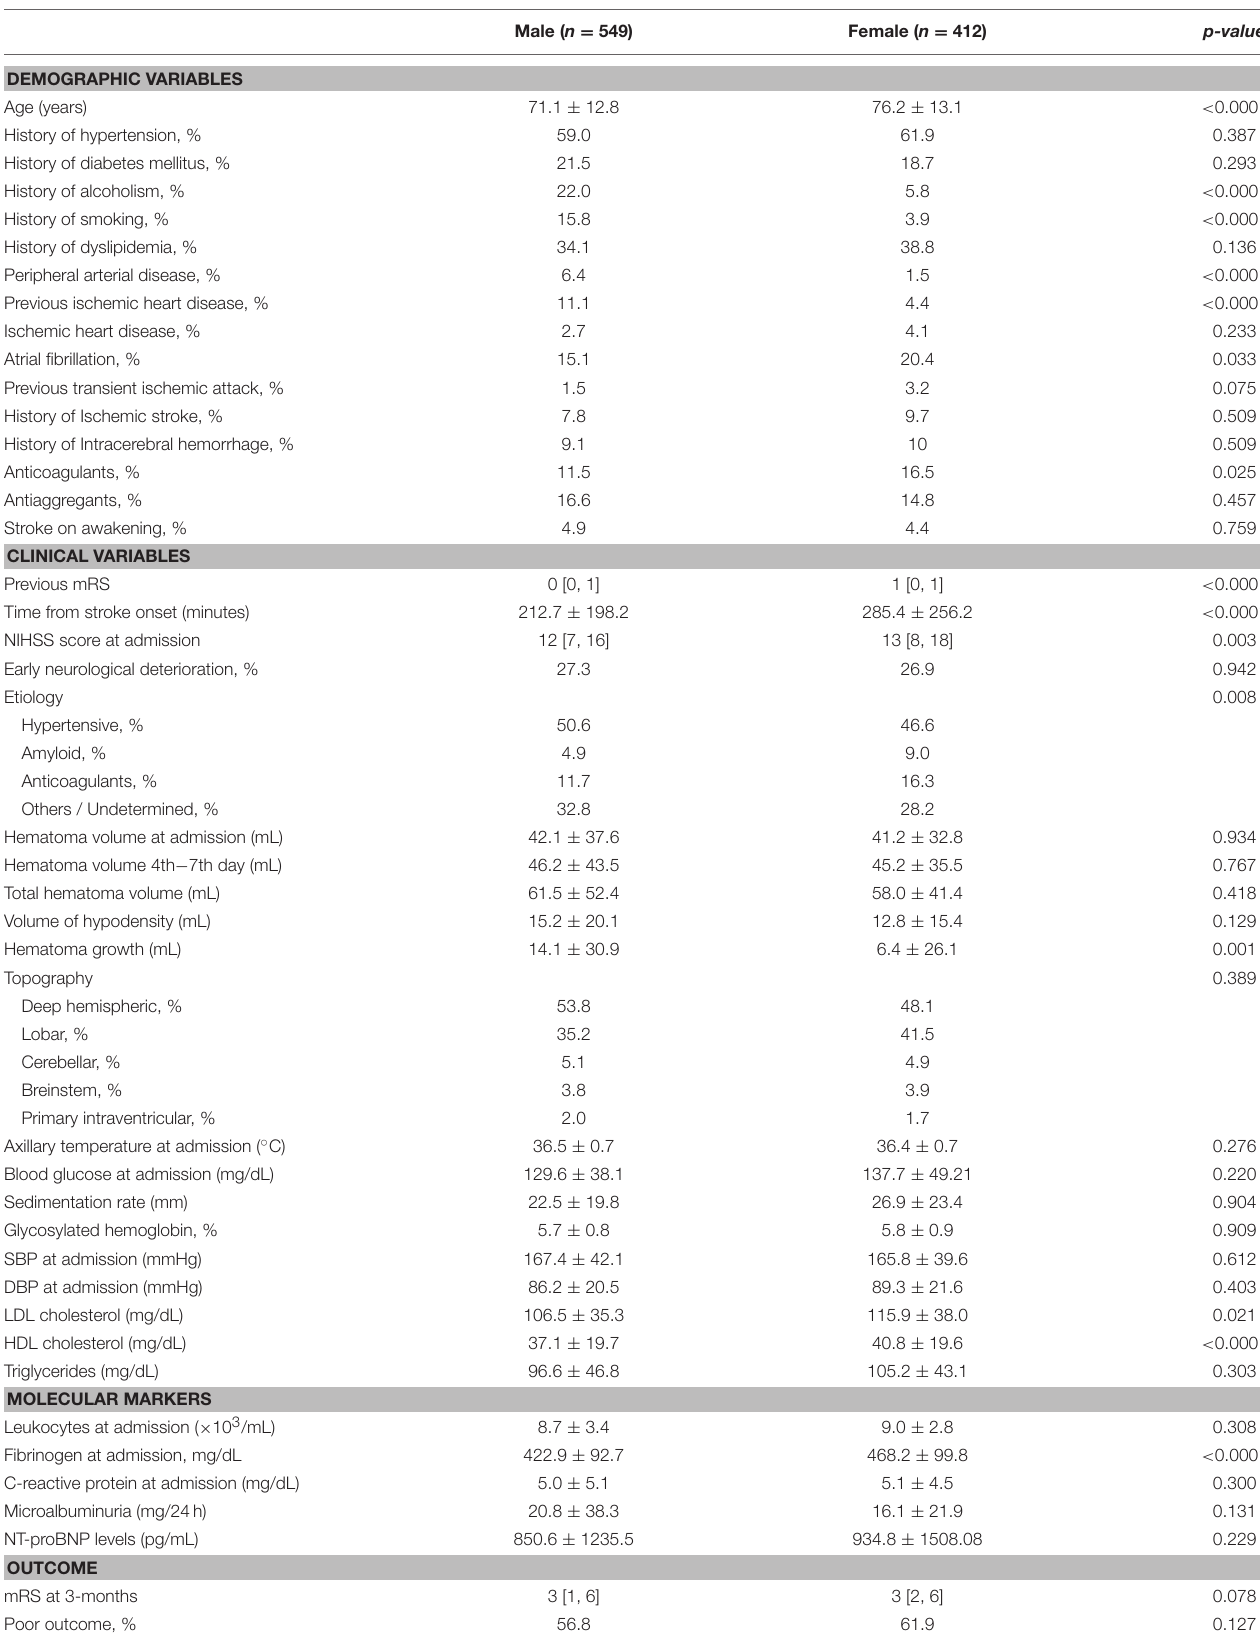
TABLE 2 | Univariate analysis according to sex in ICH patients ( n = 961). Male ( n = 549) Female ( n = 412)